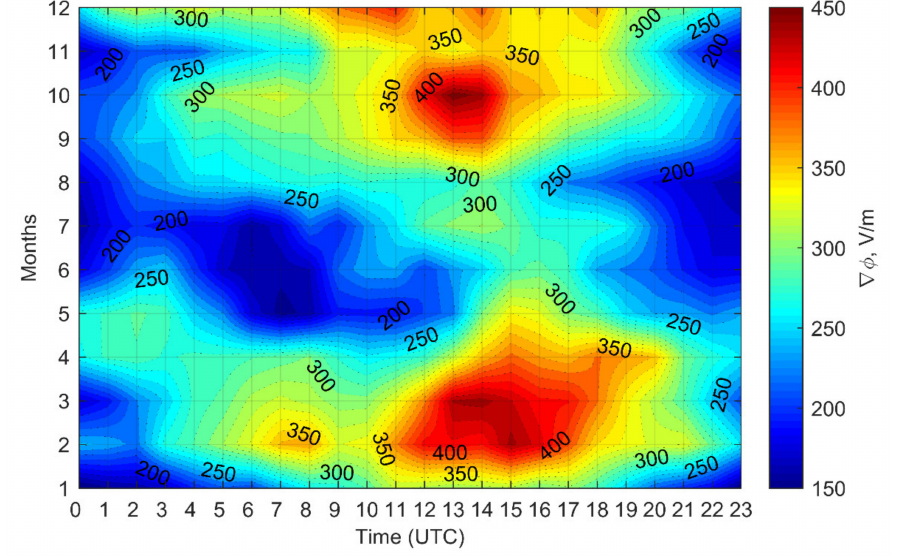
Figure 8. Hourly means of potential gradient with month of yearunder fair-weather conditions